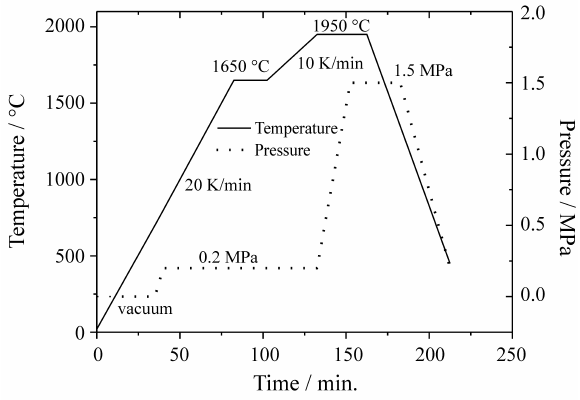
Figure 9. Calibrationcurvefor α -SiCquantitative determinationobtained by inner standard